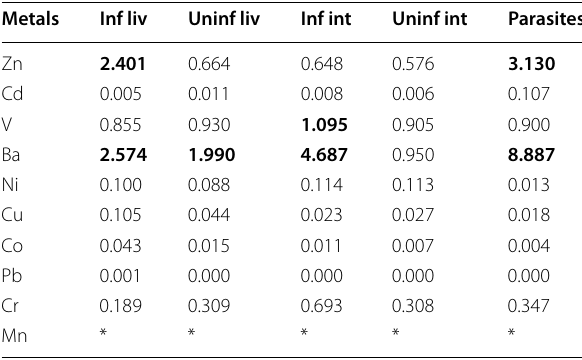
Emboldened numbers are significant bioaccumulations, asterisks represent unavailable bioaccumulation factors Inf liv liver of infected rat, unif liv liver of uninfected rat, inf int = = infected rat, uninf int intestine of uninfected =